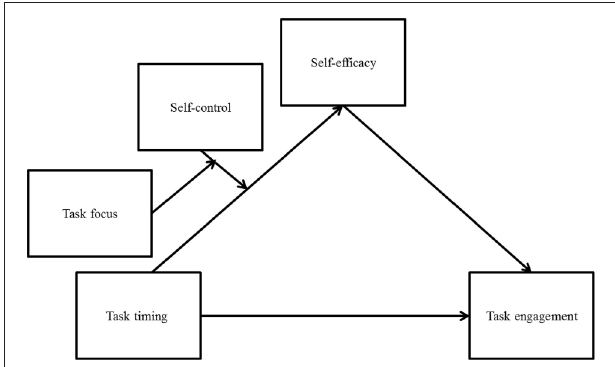
FIGURE 4 | Self-efficacy mediates the effect of task timing (near future or distant future) on task engagement dependent upon task focus (effortful focus or enjoyable focus) for different levels of